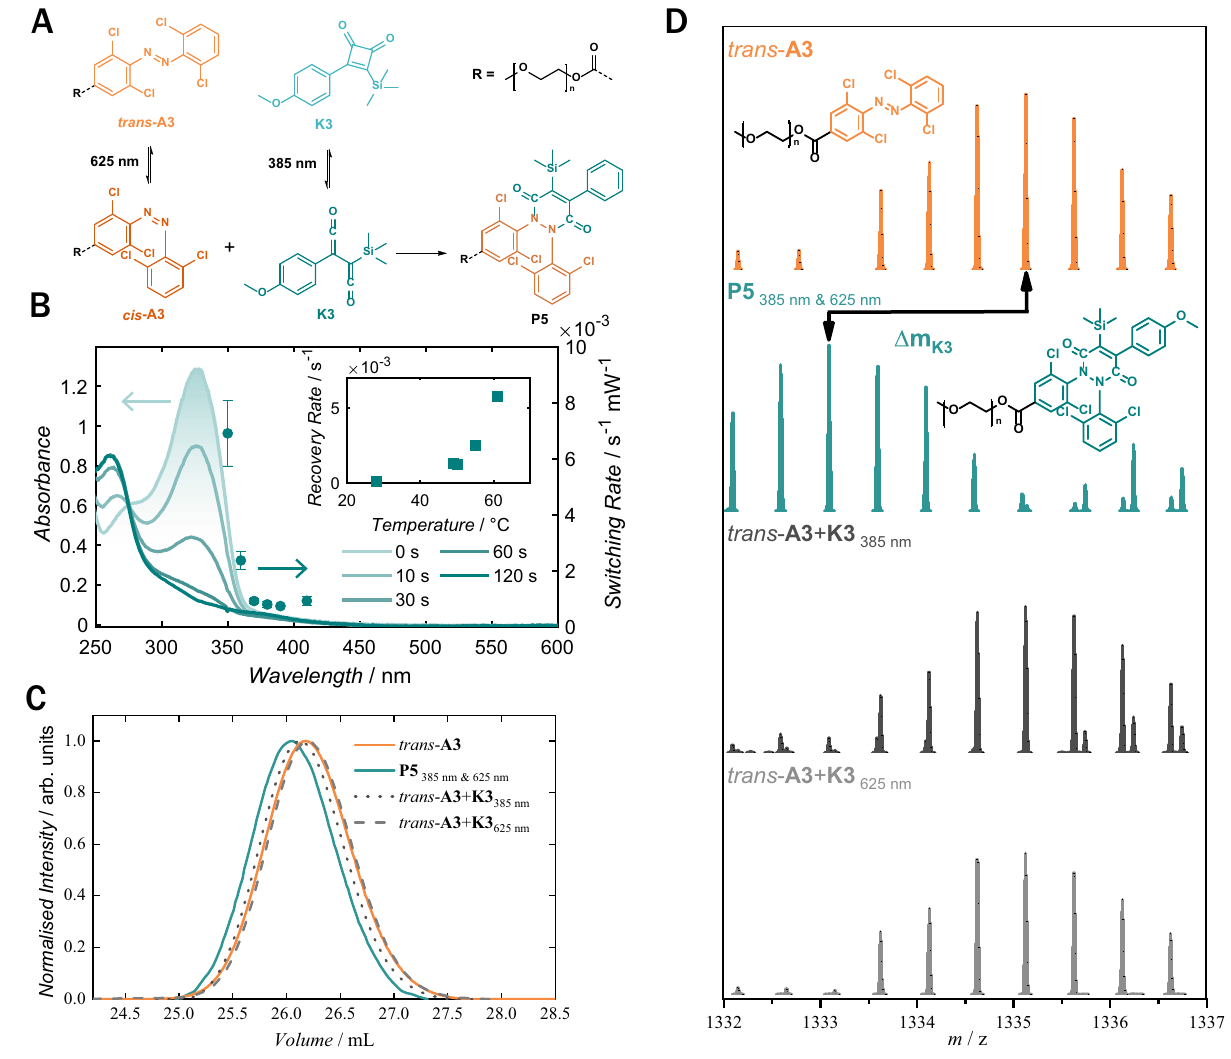
Fig. 4 Photoreversible ketene coupling. A Reaction mechanism of the two-colour light activation between A3 and K3 ; only upon exposure to 385 nm and 625 nm the bond formation takes place resulting in P4 or P5 respectively. B In situ absorbance spectrum of K3 in chloroform during exposure to 350 nm, 16 mW laser irradiation showing fast switching to the ketene K3 (left axis) overlayed with the wavelength dependent switching rate (right axis). Inset highlights the temperature-dependent thermal recovery rate of K3 . Switching rates were determined from exponential fi ts to 310 nm absorbance during irradiation. Error bars indicate variation in least squares fi t. C , D SEC and SEC-MS data of A3 (10 mmol/L in chloroform) before irradiation (orange) and after 15 min irradiation with 385 nm and 625 nm yielding P5 (turquoise). Control experiments using only one wavelength, 385 nm or 625 nm respectively, are depicted in